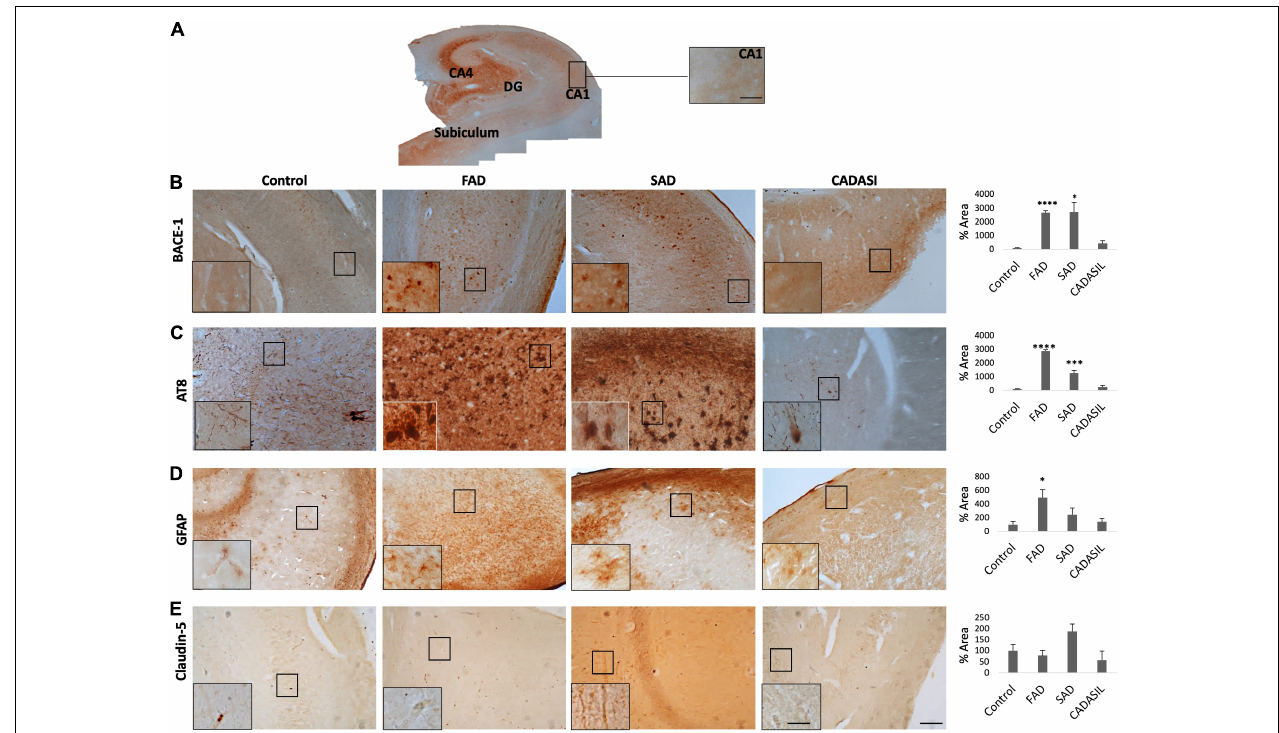
FIGURE 1 | BACE1, PHF-tau, GFAP, and CLDN5 immunoreactivities in the CA1 area of dementia brains. (A) Representative image of location in human Control hippocampus of area ca1. Magnification: 10 × . Scale bar: 25 µ m. (B) Representative images of the BACE1, (C) PHF-tau, (D) GFAP, and (E) CLDN5 immunoreactivities in the CA1 area of human hippocampal tissue. Magnification: 10 × . Scale bar: 50 µ m. Inset: 25 µ m scale bar. The values in the bar graph are expressed as a densitometric percentage of the BACE1 IR in the CA1 area. FAD, familial-type Alzheimer’s disease (presenilin 1 mutation E280A); SAD, sporadic Alzheimer’s disease; CADASIL, autosomal dominant cerebral arteriopathy with subcortical infarcts and leukoencephalopathy. The data are expressed as the means ± SEM. n = 4. ∗ p < 0.05; ∗∗∗ p < 0.001; ∗∗∗∗ p < 0.0001.